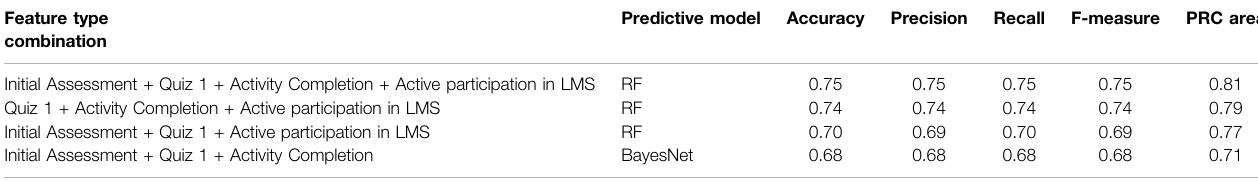
TABLE 3 | Feature types of a combination comparison for performance prediction of students ’ second module quizzes.